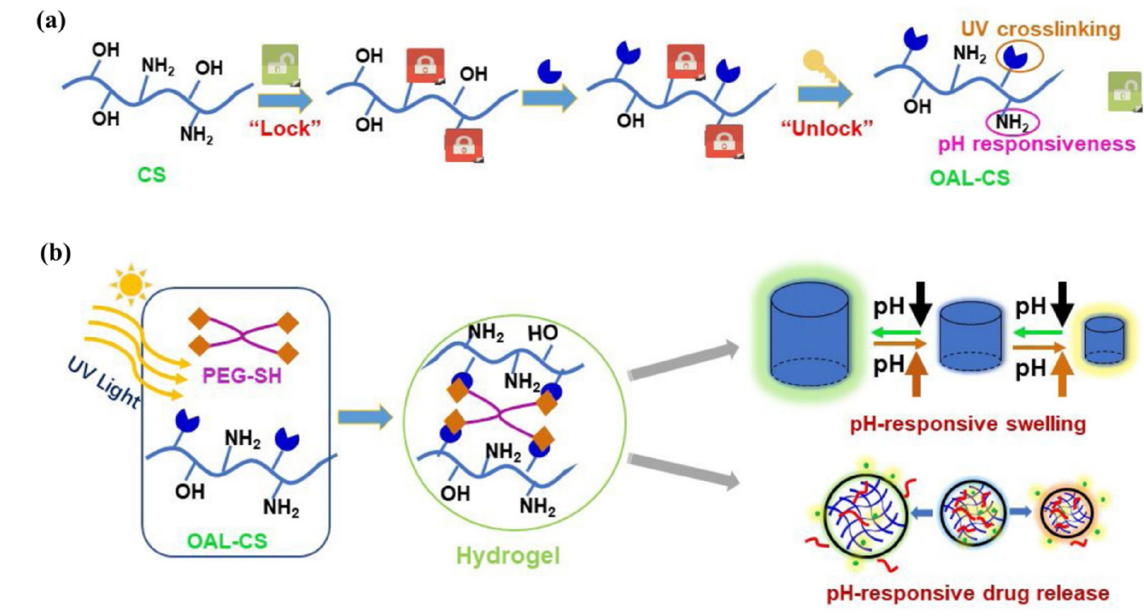
Figure 20. Schematic synthesis of ( a ) pH-responsive UV-crosslinkable C 6 O-allyl chitosan (OAL-CS) via protection/depro- tection of amino groups and ( b ) the OAL-CS hydrogel via UV-triggered “thiol-ene” click chemistry in which 4-arm PEG- SH served as crosslinker, as designed by Ding et al. Reprinted with permission from [88]; published by Elsevier, 2020.